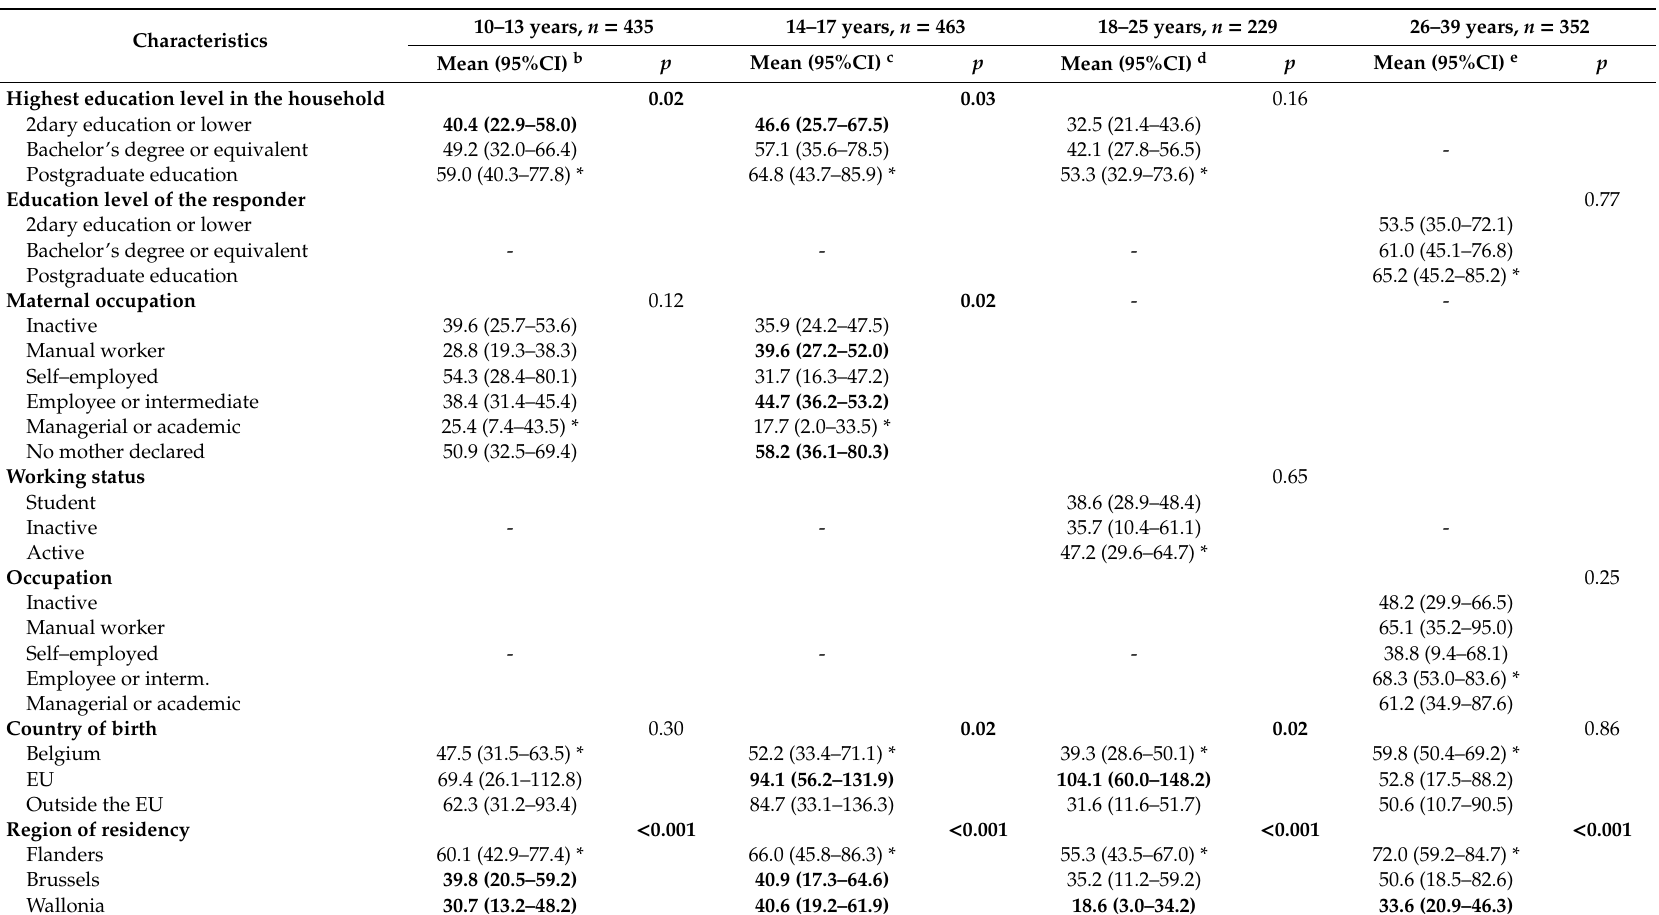
Table 3. Adjusted a mean consumption (g / day) of whole grain bread and cereals according to socio-economic and cultural characteristics, and age group. Belgian food consumption survey